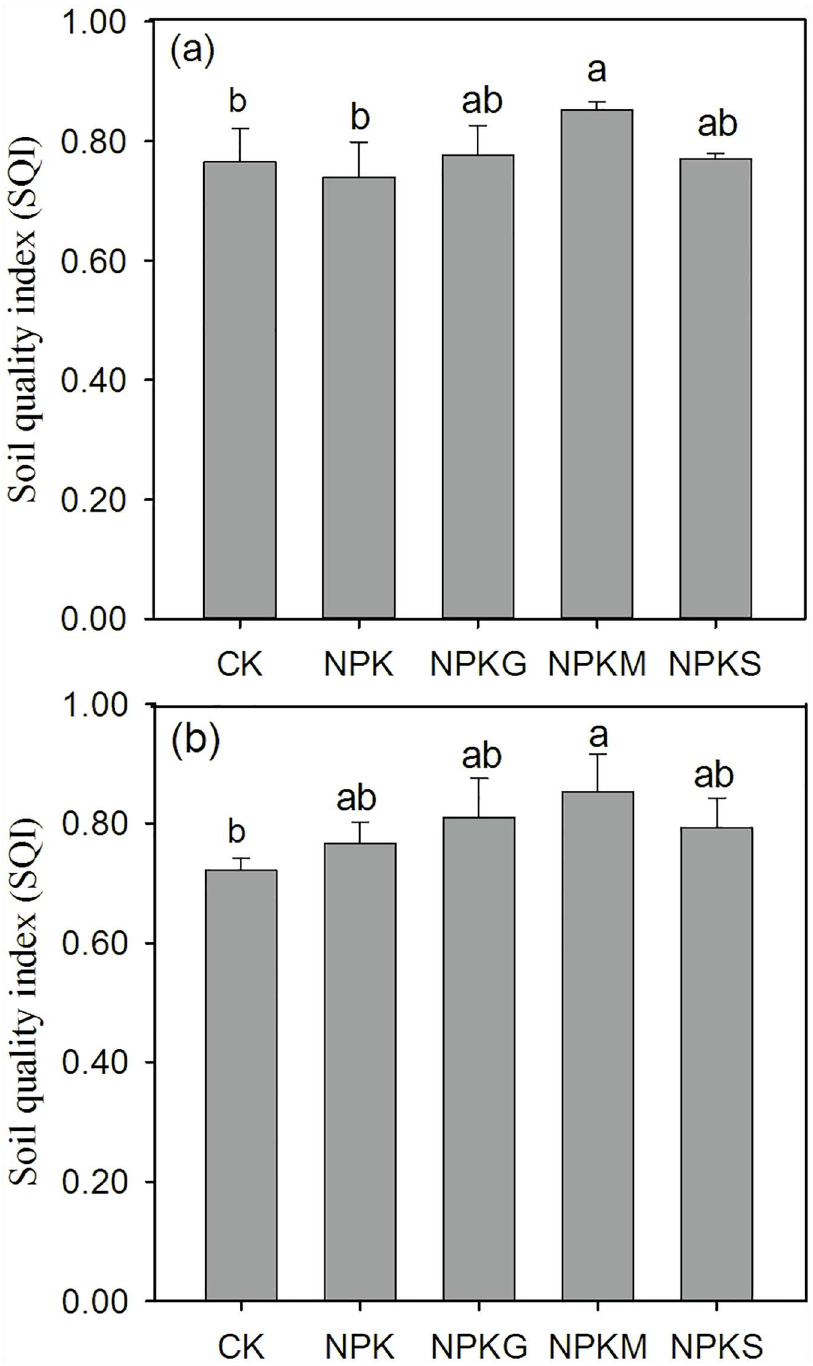
Fig 7. Variations in Soil Quality Index (SQI) under different fertilizations in the late rice season of 2012 (a) and the early rice season of 2013